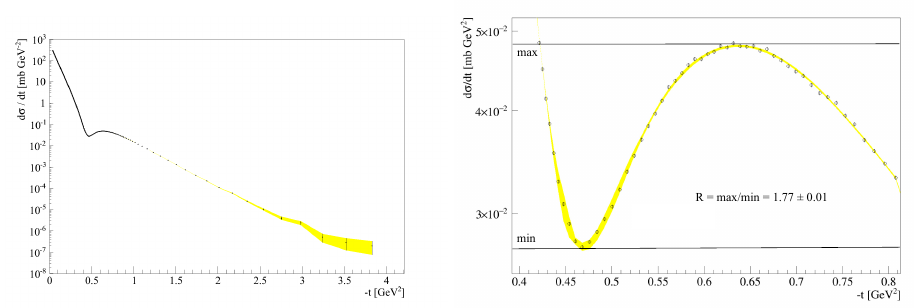
Figure 7. Left panel: TOTEM data for the di ff erential cross-section of elastic pp scattering at t -dependent correlated systematic uncertainty envelope √ s = 13 TeV, from ref. [3]. The statistical and | | is indicated by a yellow band. Right panel: The same TOTEM data for the di ff erential cross-section of elastic pp scattering at √ s = 13 TeV as on the left panel, but zooming in to the dip-and-bump region.